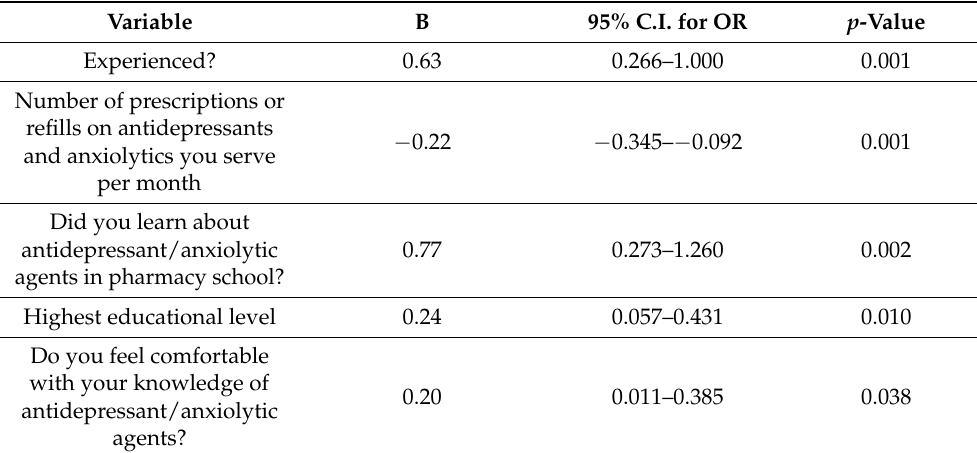
Table 6. Predictors of higher knowledge